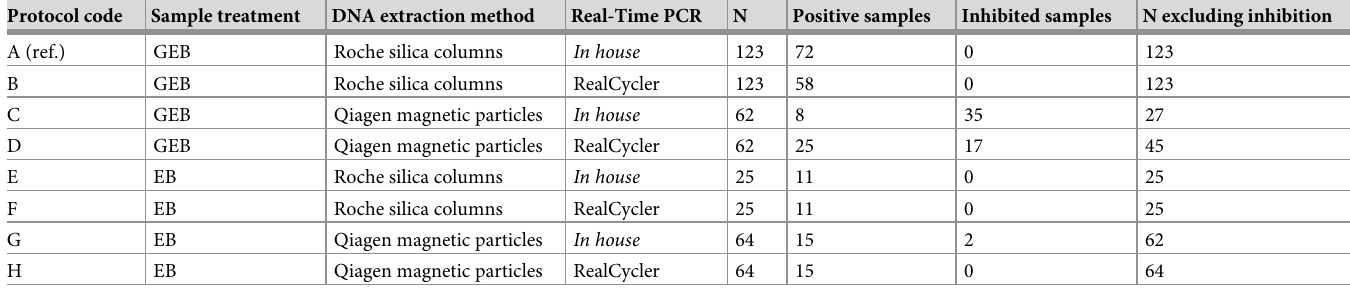
Table 1. Trypanosoma cruzi diagnostic Real-Time PCR results of samples analysed according to the protocols used in the study based on the combination of differ- ent sample treatments, DNA extraction methods and Real-Time PCR procedures. Protocol code Sample